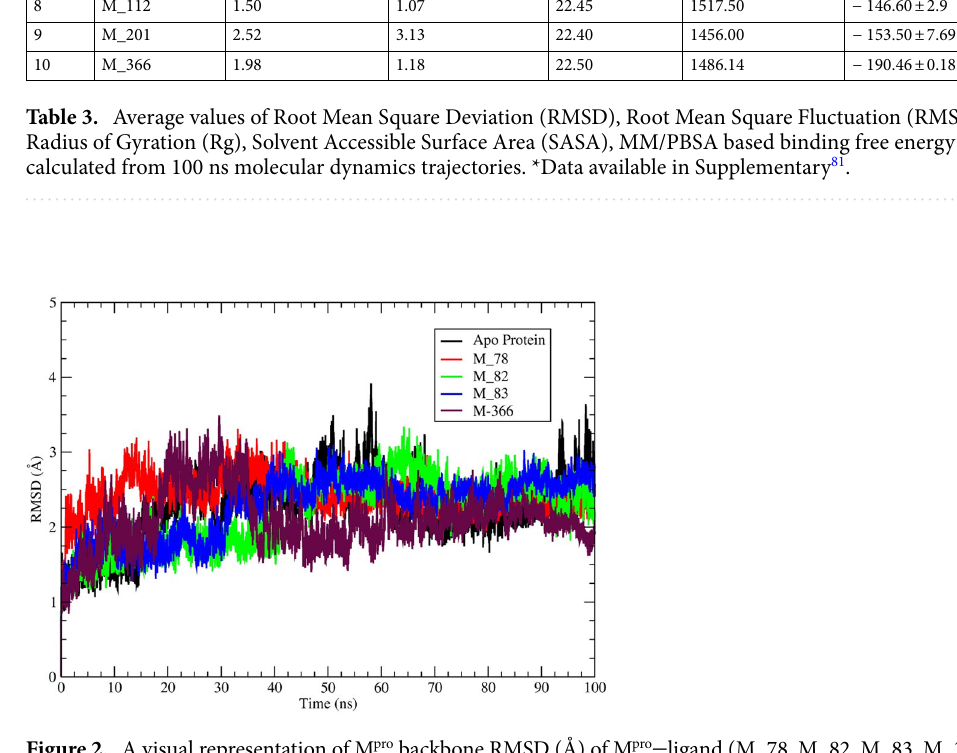
Figure 2. A visual representation of M pro backbone RMSD (Å) of M pro ‒ ligand (M_78, M_82, M_83, M_366) complexes and apo-protein obtained from 100 ns MD simulation trajectories. Different ligands represented by different